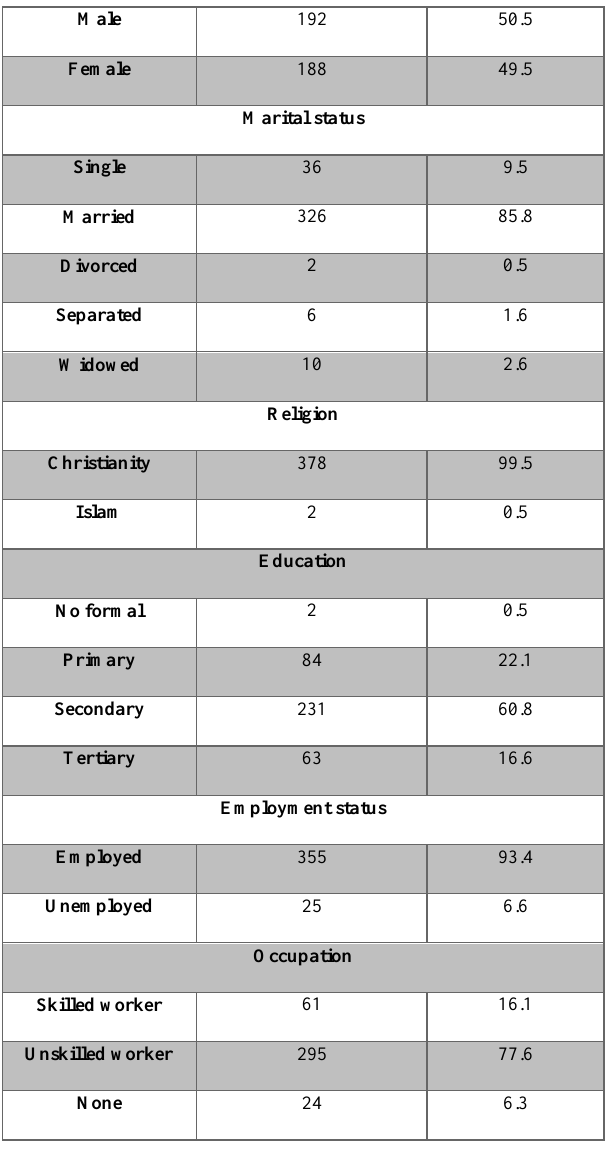
Fig. 1. Prevalence of partner disclosure of HIV seropositive status. Most of the participants (91.8%) had disclosed their positive HIV status to their steady sexual partners, while 8.2% did not disclose. Table 3. HIV Serodiscordance Rate.